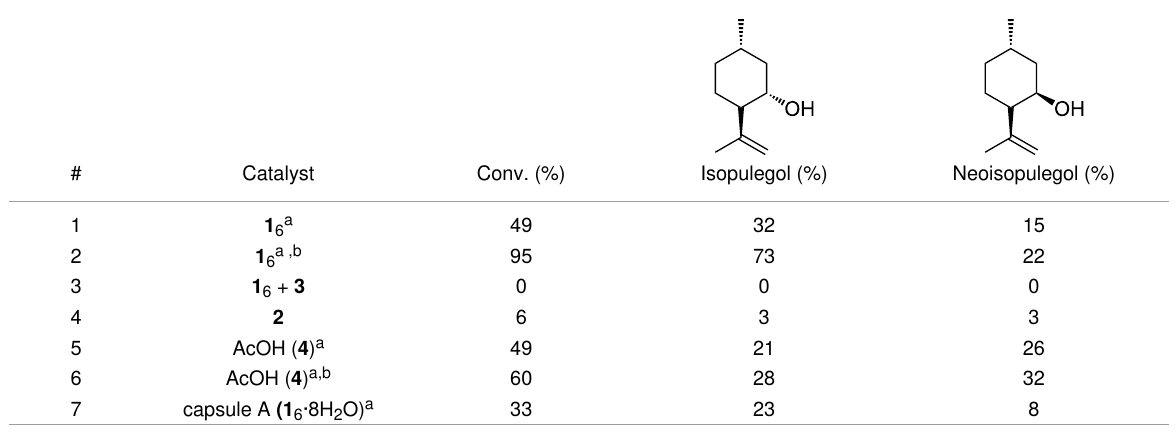
Table 1: Conversion and selectivity for the carbonyl–ene isomerization of ( S )-citronellal at 60 °C for 24 h.